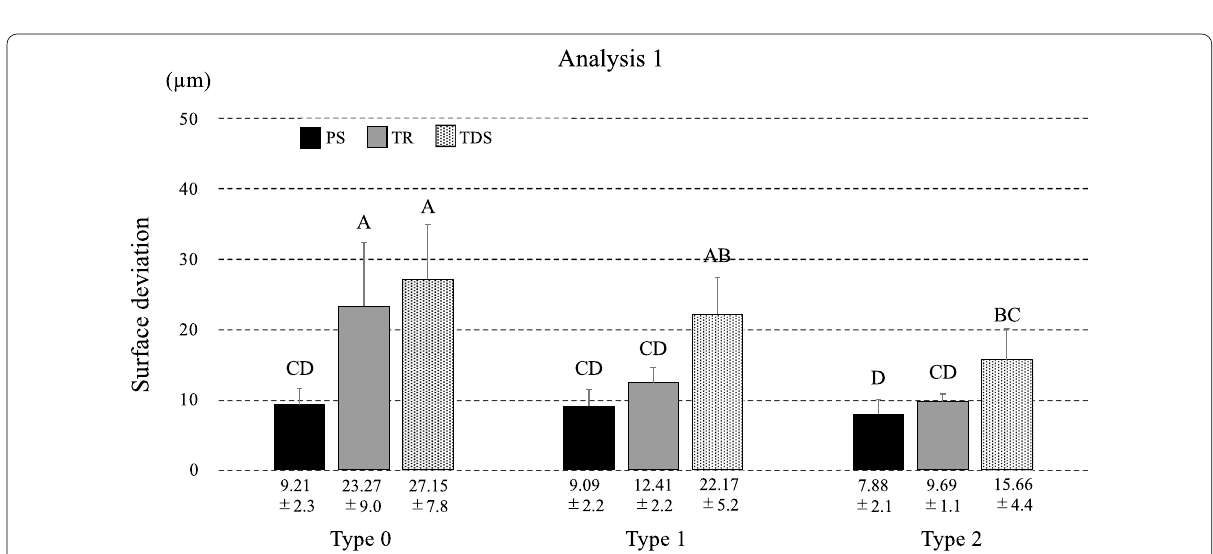
Fig. 5 Average discrepancy in each type for each IOS in analysis 1 (µm). The lines on the bars of the bar graph indicate the standard deviation of the measured discrepancies. IOS intra-oral scanners, PS Primescan, TDS true definition scanner, TR TRIOS3